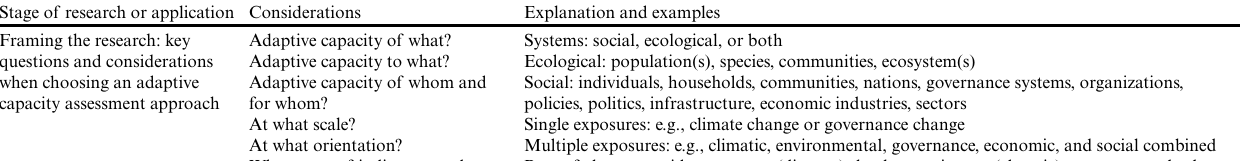
Table 3. Key considerations for operationalizing adaptive capacity research and